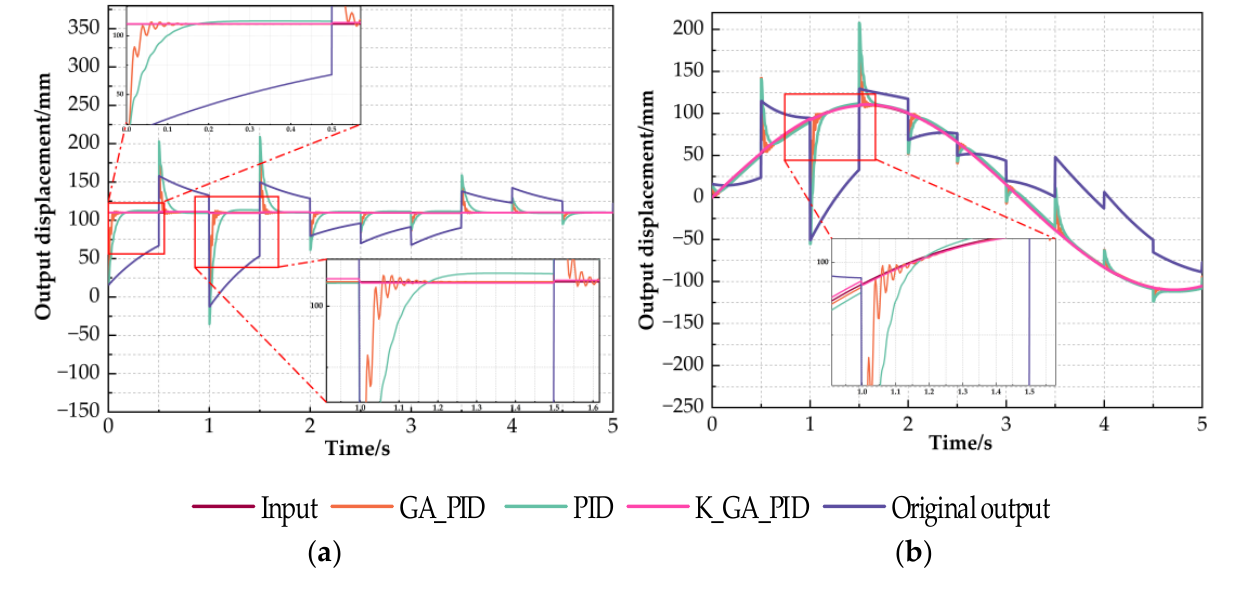
Figure 12. 0.002 energy white noise.